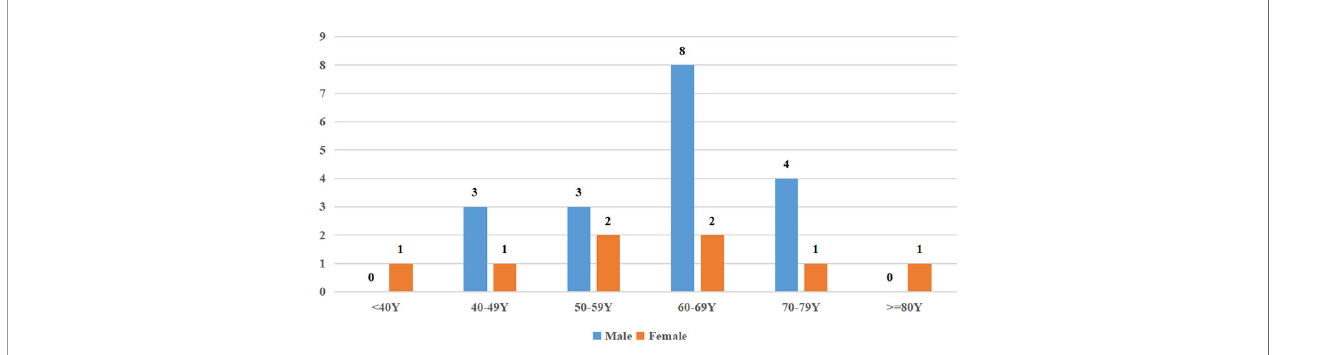
FIGURE 1 | Age distribution of PAL in this series.